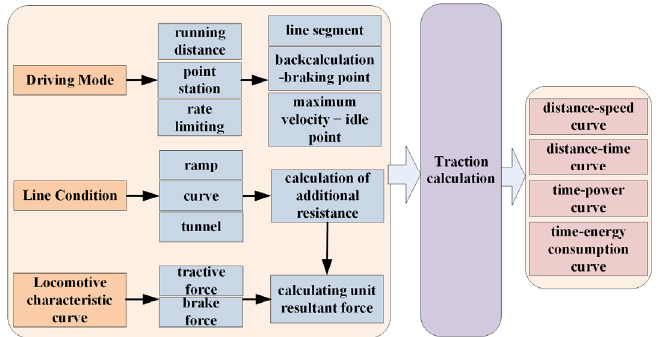
Figure 4. The framework of traction calculation.